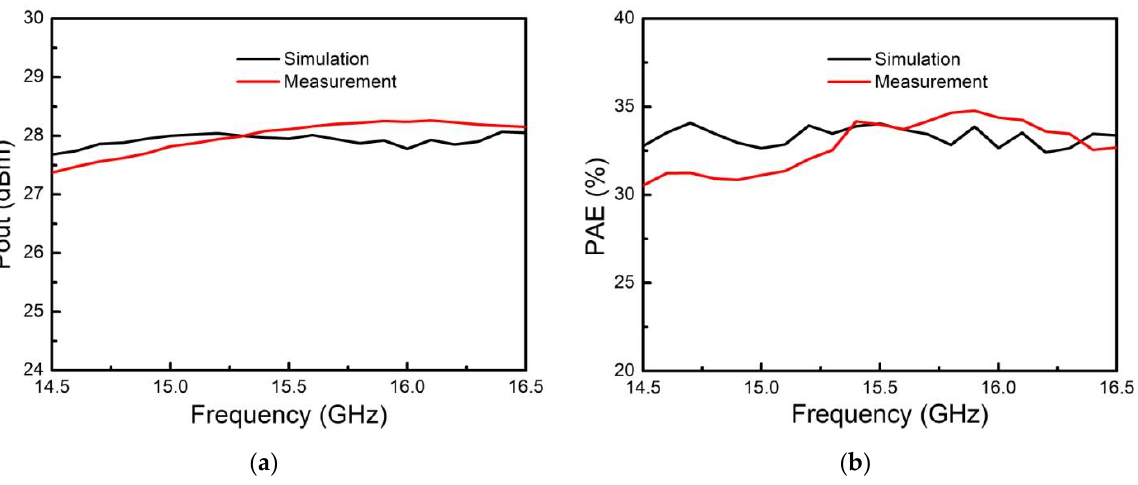
Figure 10. Comparison of simulation and measurement of the proposed Ku-band SIP in transmitting state. ( a ) Simulated and measured saturated output power curve; ( b ) Simulated and measured power added efficiency curve.